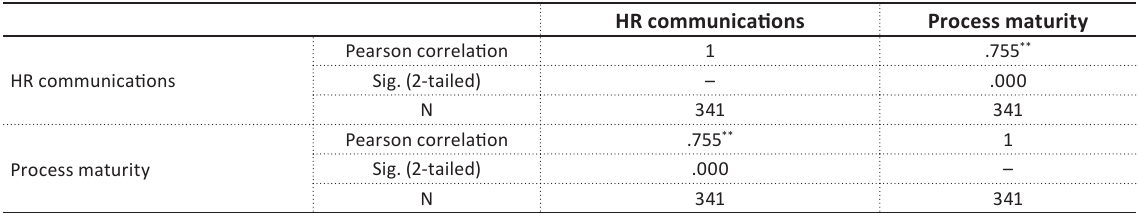
Table 3. Correlation analysis between HR communications level and process